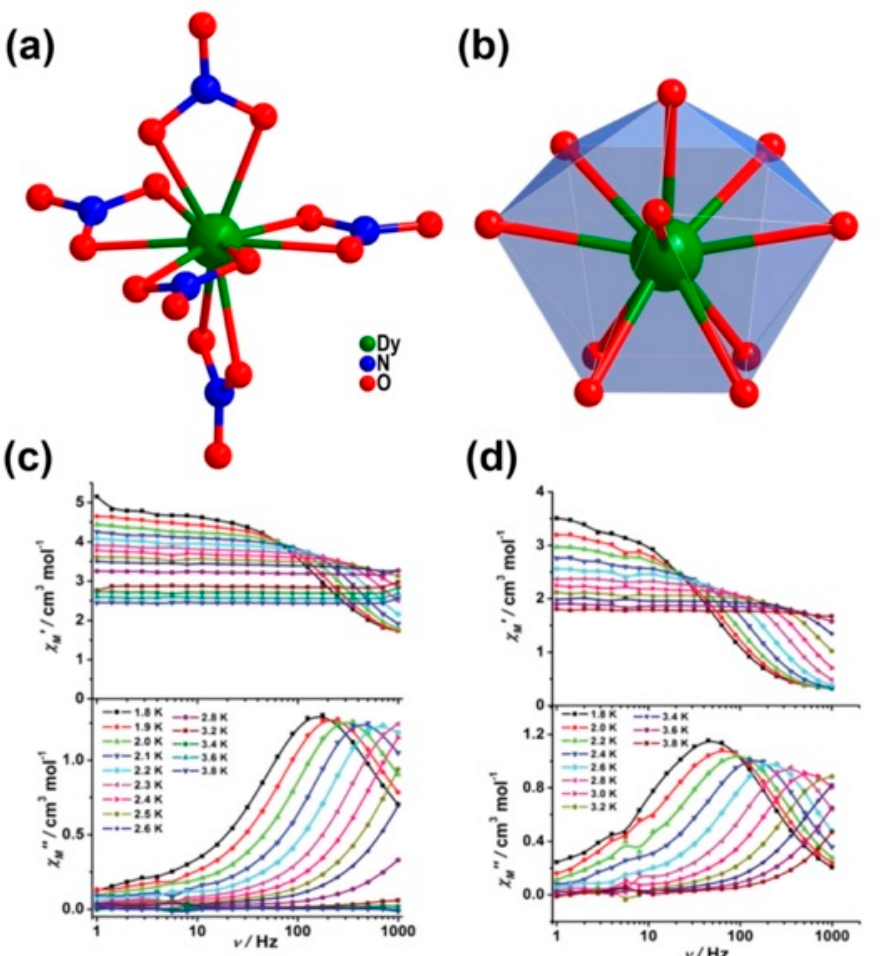
Figure 24. Molecular structure of the anionic part of ( a ) and the corresponding coordination geometry ( b ) of 39 ; Frequency dependence of the AC susceptibility under a DC field of 500 Oe for 39 ( c ) and 1000 Oe for 40 ( d ). Figures and captions are reproduced from Reference [60] with permission from the Royal Society of Chemistry.